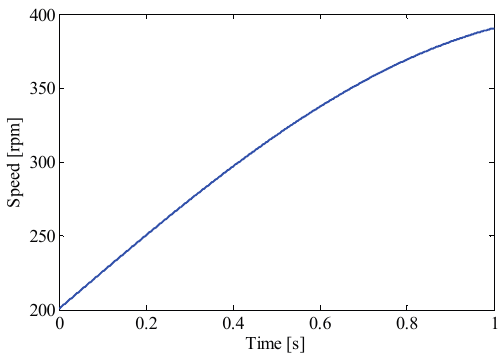
Figure 3. The speed curve of a bearing.